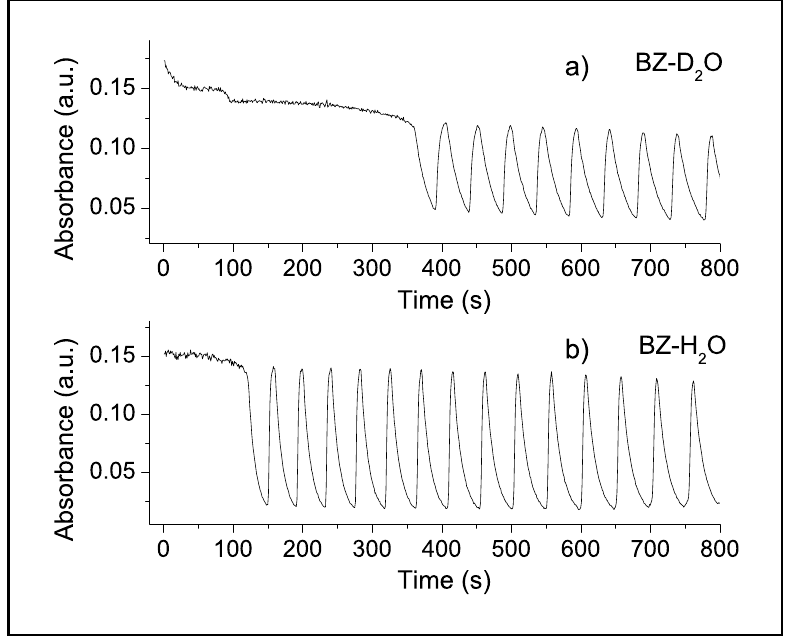
Figure 1. Comparison between a BZ reaction in D were recorded at l = 320 nm where Ce(IV) has an absorption maximum. For both systems the following reactants concentrations were used: [MA] = 0.1 M, [BrO 3- ] = 3 x 10 -2 M, [H